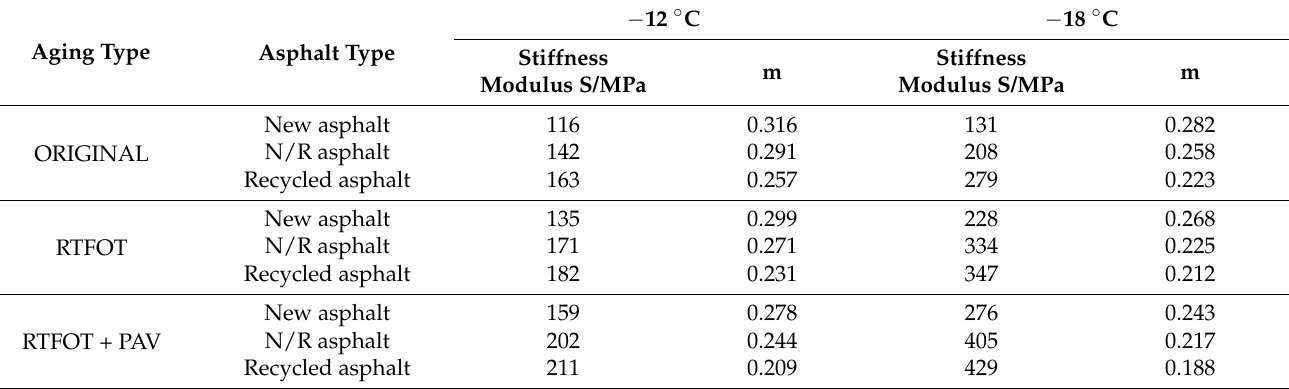
Table 2. BBR test results of the three